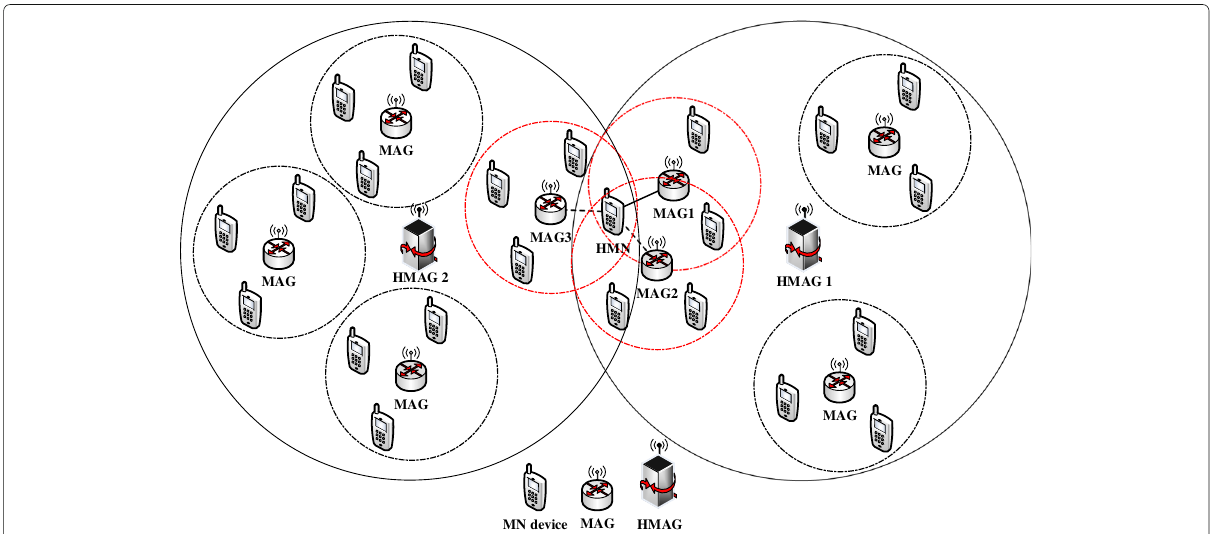
Fig. 5 An example of CSPMIPv6 inter-structure for load balancing